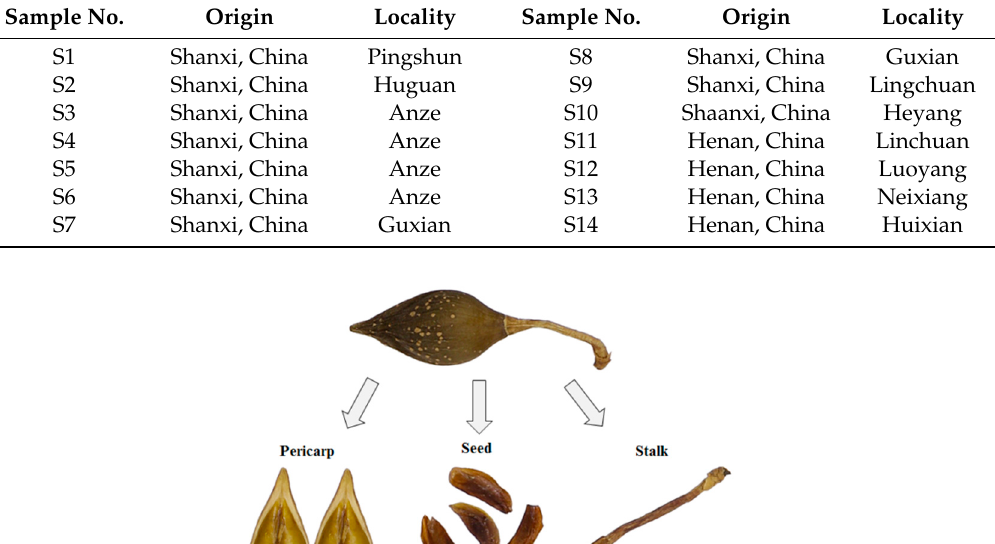
Table 3. Sample information of Forsythiae Fructus.